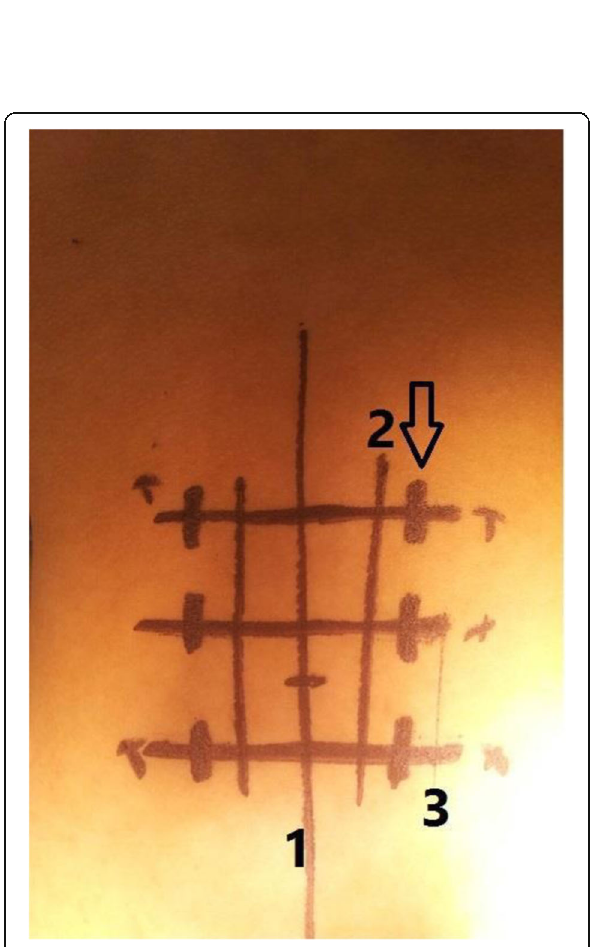
Fig. 3 1. Midline of the back. 2. Line drawn targeting lateral margins of the pedicles. 3. Arrow indicating the incision site 1 cm lateral to the lateral margin of the